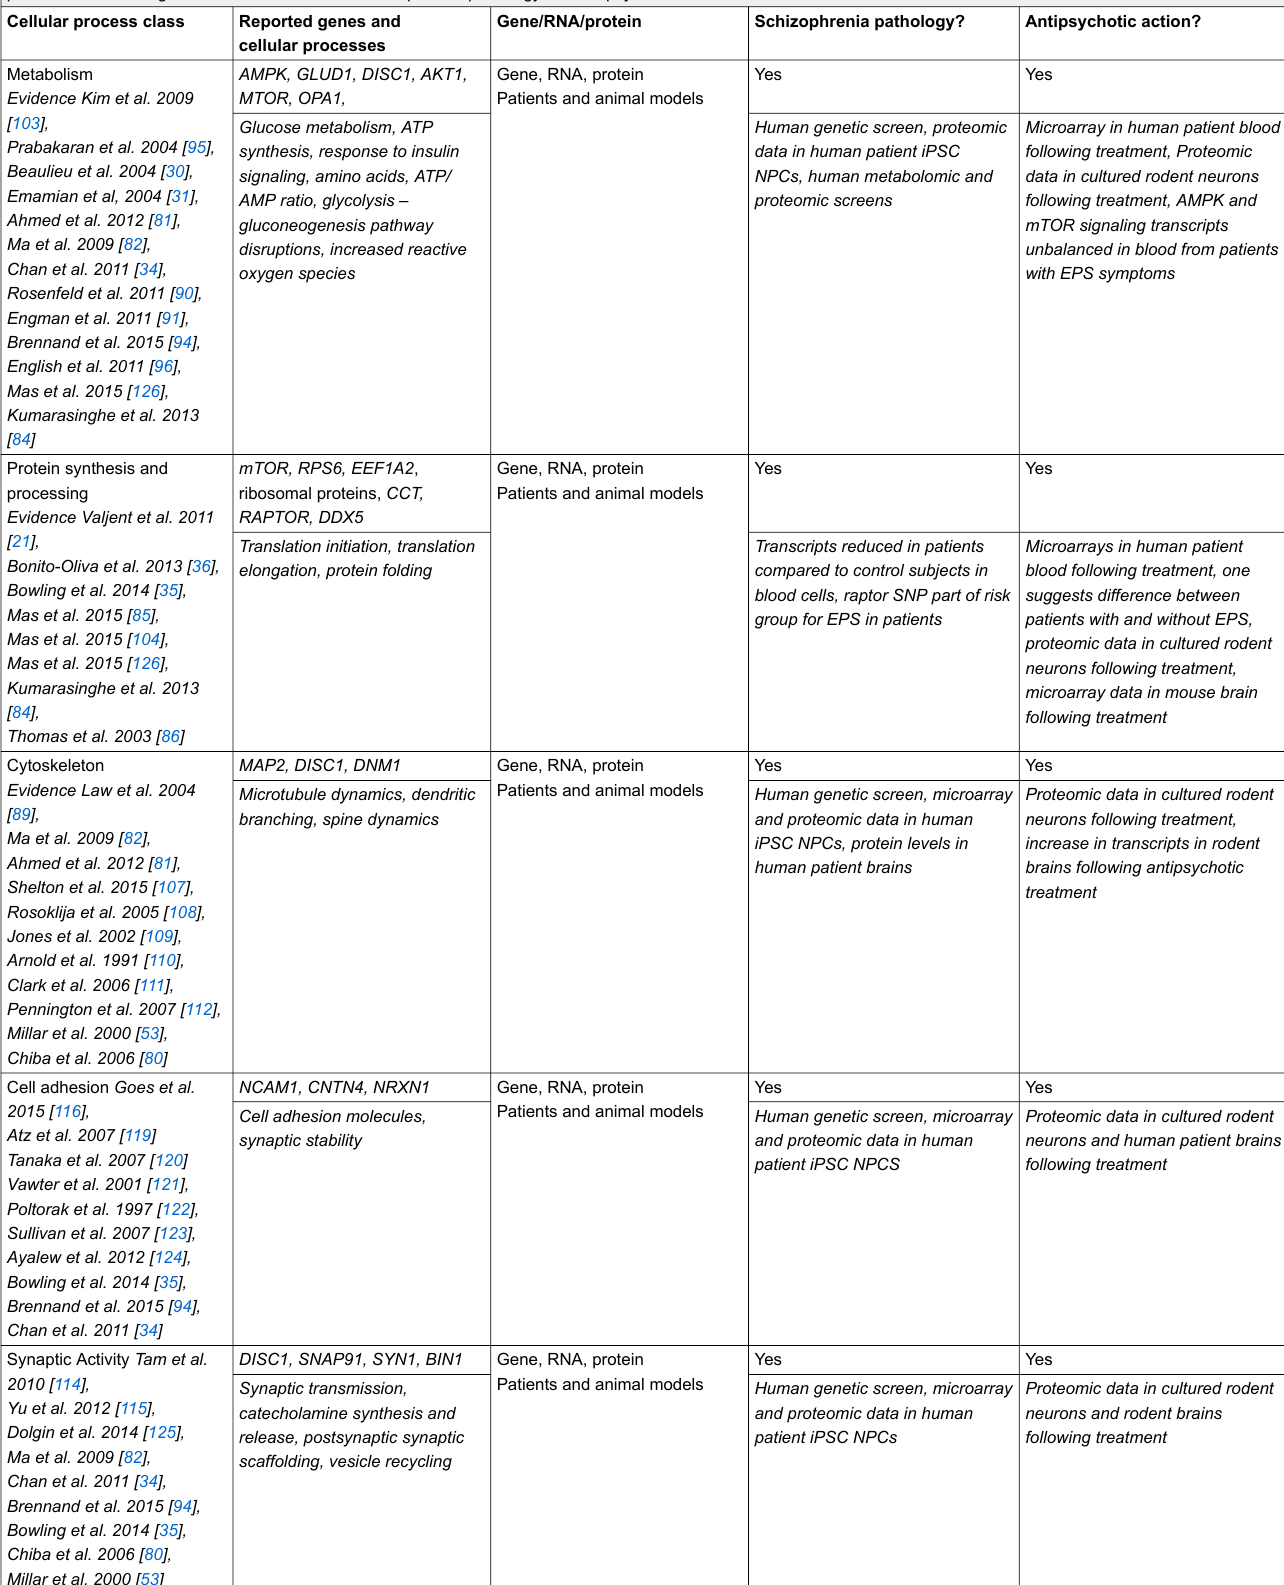
Table 1: Cellular processes that are affected in schizophrenia patients and targeted by antipsychotics. Cellular processes with at two or more genes and multiple publications selecting their involvement in both schizophrenia pathology and antipsychotic action. Cellular process